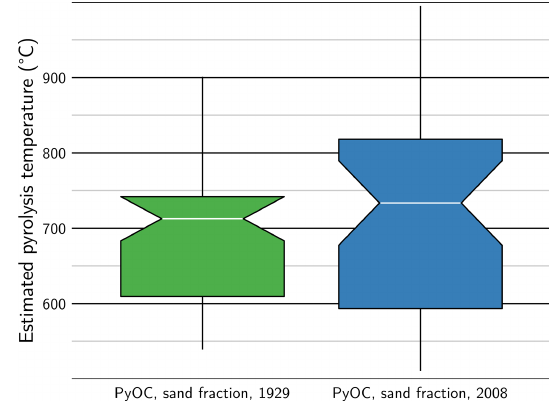
Figure 5. Box-and-whisker plot of burning temperature estimated from Raman spectra obtained on individual grains of pyrogenic or- ganic carbon in the sand fraction of long-term bare-fallow soils sam- pled in 1929 and 2008 (PyOC: pyrogenic organic carbon). The box is limited by the first and third quartiles of the data distribution. The horizontal line represents the median, and the width of the adjacent notches shows the 95% confidence interval about the median. The “whiskers” represent the last value before the 1.5 times mid-range (the arithmetic mean of maximum and minimum values) beyond the first or third